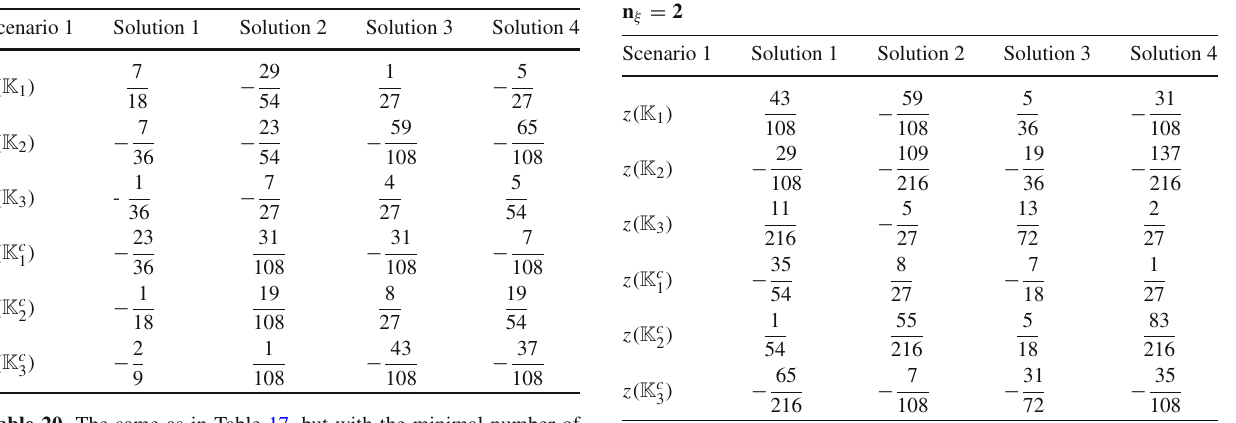
Table 19 The same as in Table 17, but with the minimal number of singlets under the SM gauge group n ν c = 6 , n S = 4 and n N = 1